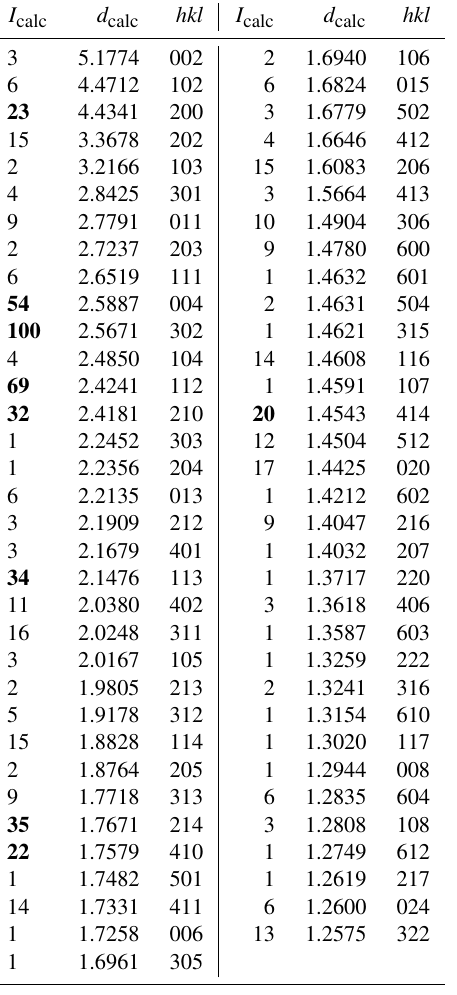
Table 3. Calculated X-ray powder diffraction pattern ( d in angstroms) for ellinaite from the Hatrurim Basin.